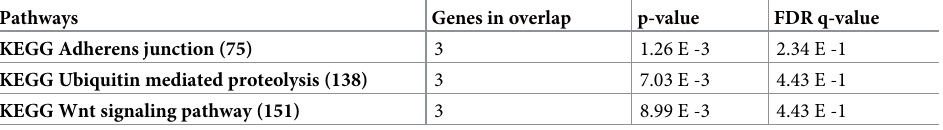
Table 8. Results from overlap analyses, Category 3. Pathway analysis of genes mutated exclusively in metastases, 129 in total.